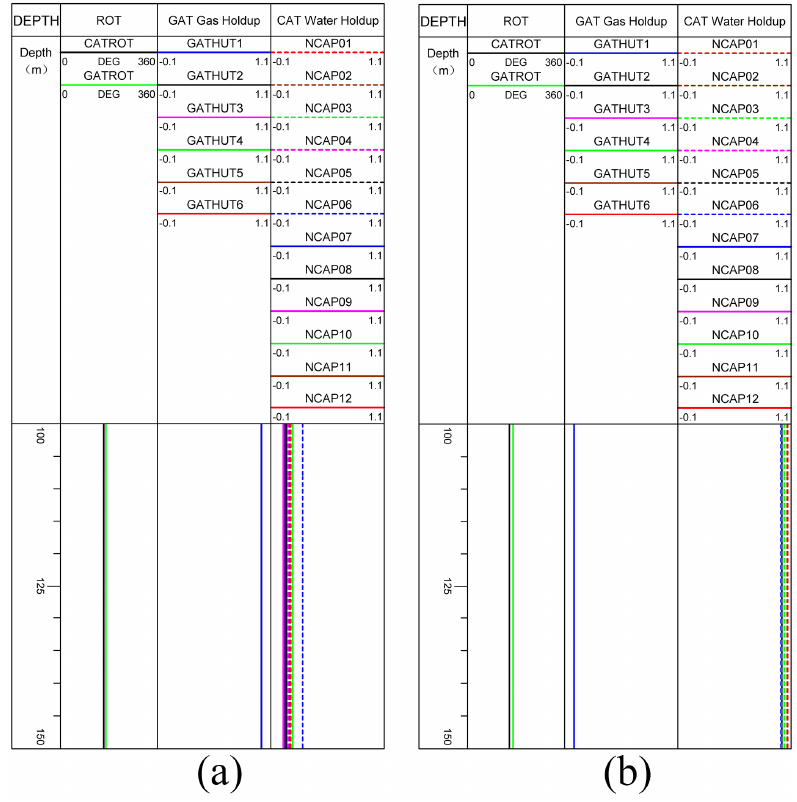
Figure 5. Instrument calibration data. ( a ) Pure gas calibration, ( b ) Pure water calibration.